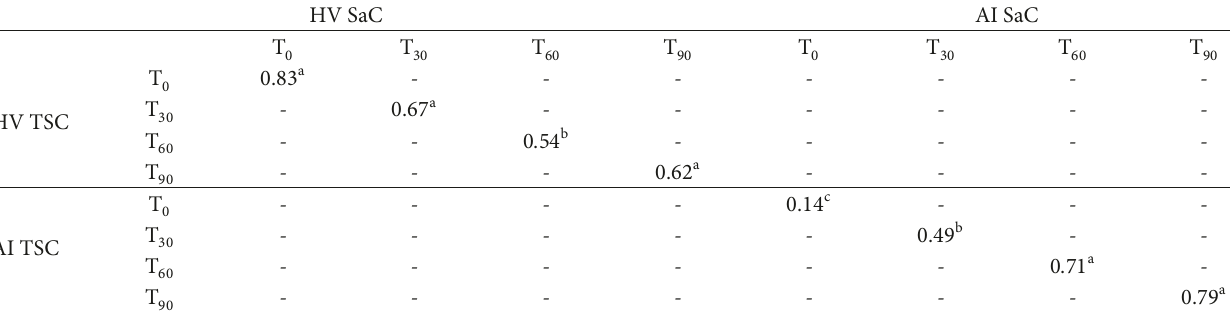
Table 6: Pearson correlation (r) between serum and salivary cortisol concentrations in healthy volunteers and adrenal insufficient patients at different timepoints during the ACTH test.